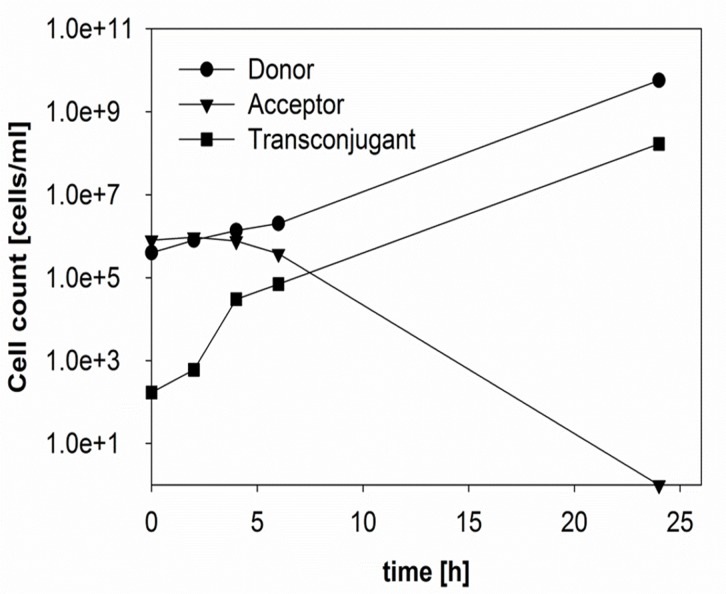
Transfer of pESBL-283 from ESBL242 (donor, ampR) to E. coli MG1655 (acceptor, chlorR) in a ratio of 1:1 with 8 μg/ml ampicillin and 4 μg/ml clavulanic acid.